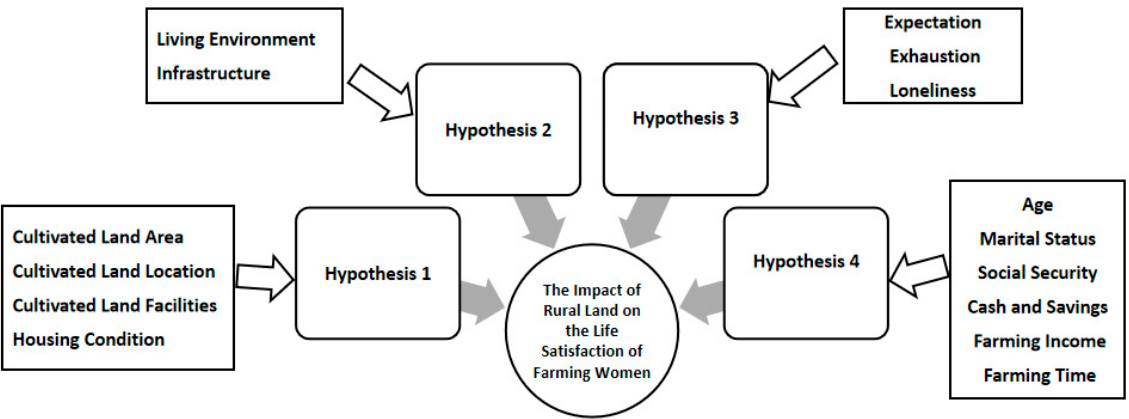
Figure 2. Research hypotheses proposed. Source: Authors’ own construction.